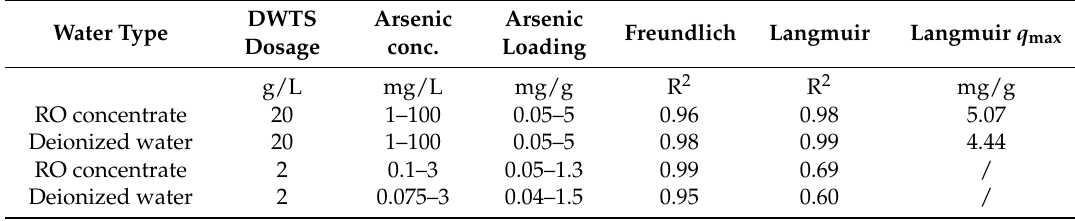
Table 2. Isotherm parameters of arsenic sorption onto